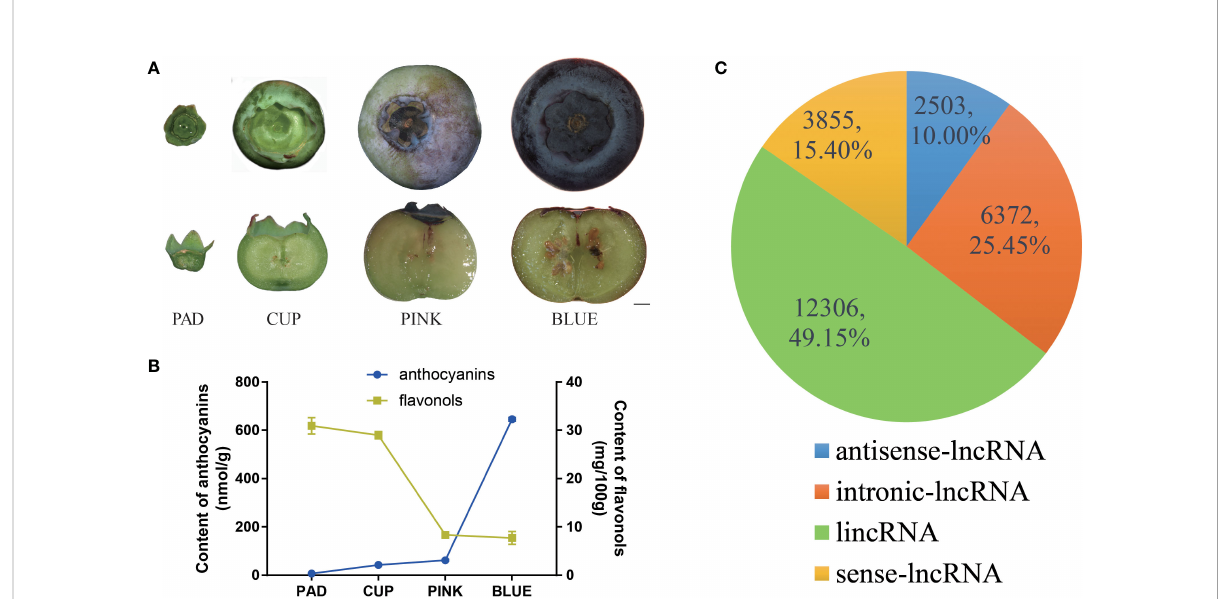
FIGURE 1 Identi fi cation and classi fi cation of blueberry lncRNAs in blueberry. (A) Whole phenotype and longitudinal section of ‘ Misty ’ fruits at the four developmental stages. Scale bar = 2 mm. (B) The content of anthocyanin and fl avonols. (C) All lncRNAs were classi fi ed as long intergenic non- coding RNAs (lincRNAs), antisense lncRNA, intronic lncRNA, and sense lncRNA, with the number and percentages shown in the pie